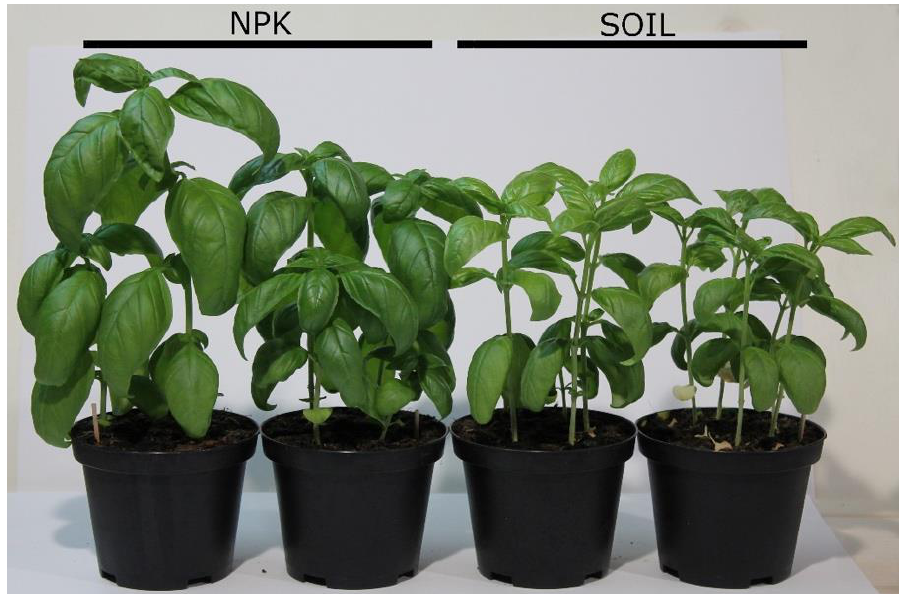
Figure 6. Basil plants obtained under 1HR:1DB LED lights.